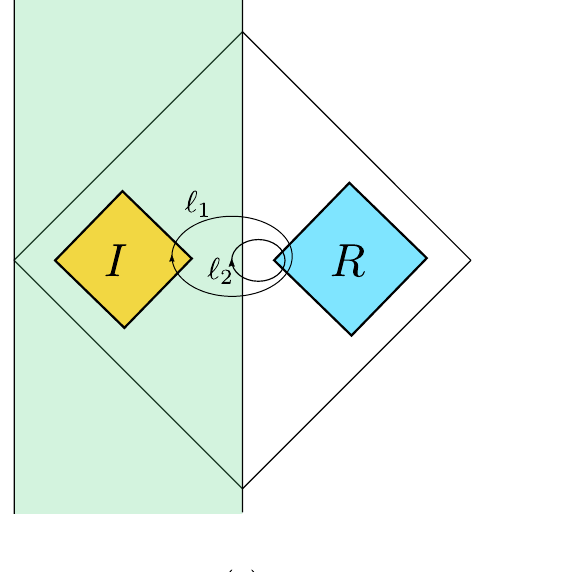
JHEP03(2021)040